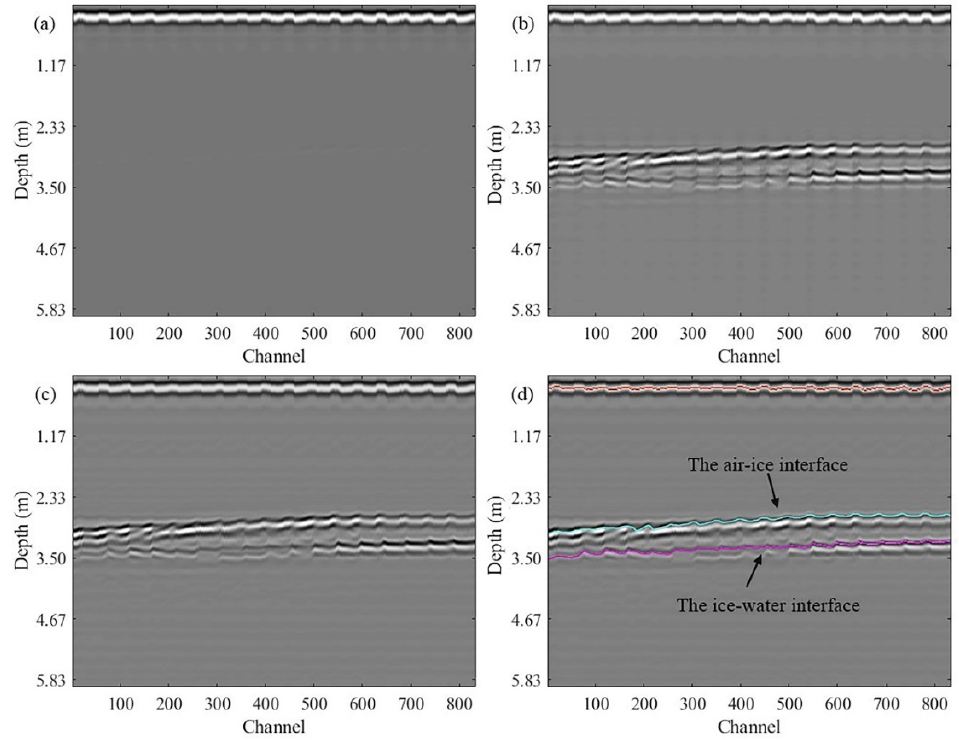
Figure 2. The process of GPR profile image including resampling ( a ), Gain–adjusted ( b ), FIR filtered ( c ), and layer–tracking ( d